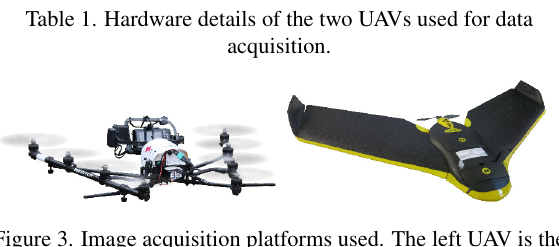
Figure 3. Image acquisition platforms used. The left UAV is the Falcon8 from Ascending Technologies GmbH and the right one the eBee from SenseFly.